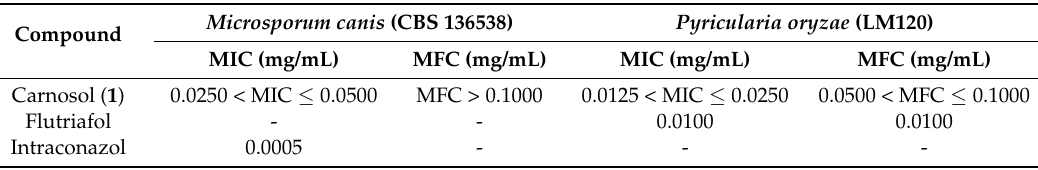
Table 3. MIC and MFC of carnosol against M. canis and P.